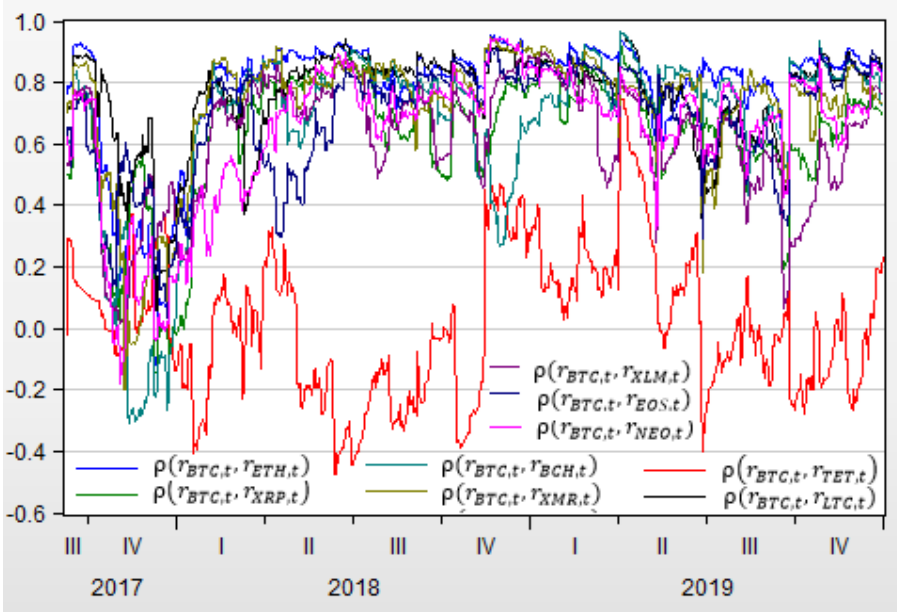
Figure 5. Curves of the DCC between Bitcoin and the other nine cryptocurrencies for the pre-COVID-19 period.